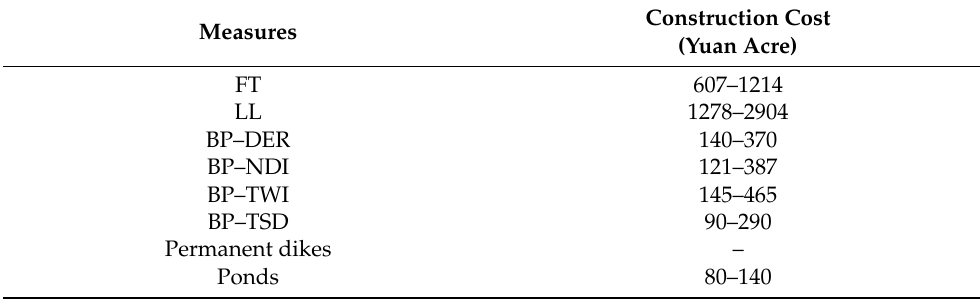
Table 5. Construction costs of BMPs.